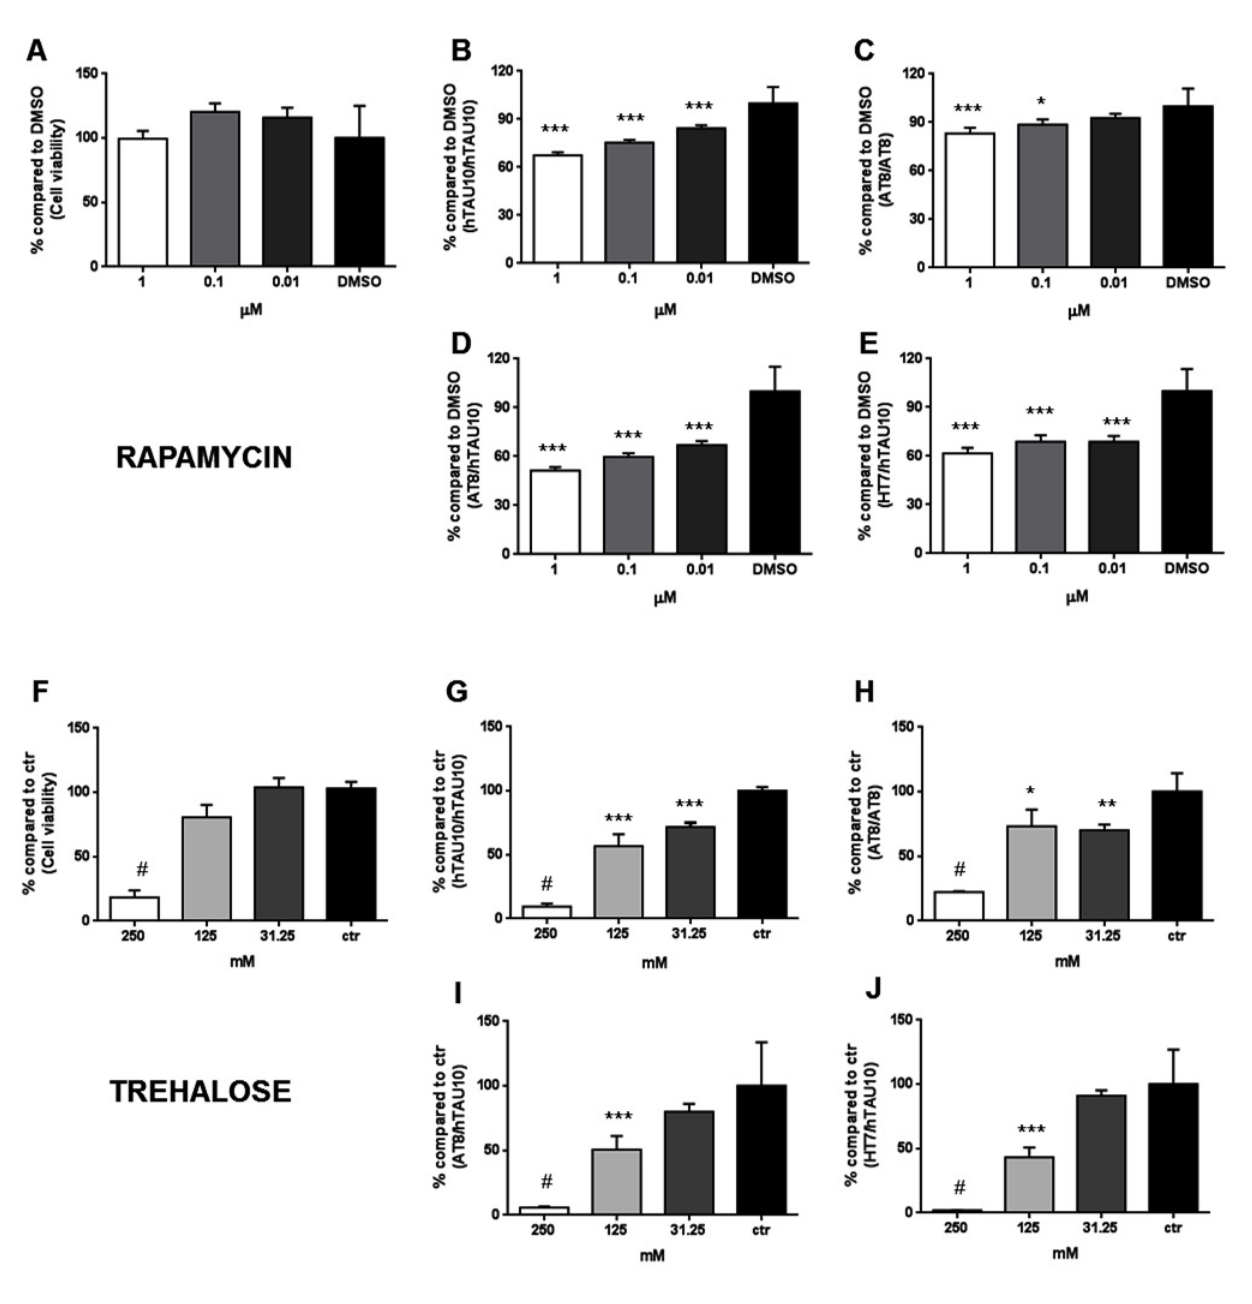
Fig 5. Model validation: autophagy inducers reduce TAU hyperphosphorylation and aggregation in TAU-P301L neurons. (A) CellTiter-Glo 1 data showing that rapamycin is not toxic (P = NS). (B, C) Rapamycin dose-dependently reduces hTAU10 (P < 0,001; B) and AT8 aggregated TAU measured with AlphaLISA (P = 0,025 at 10 nM and P < 0.001 at 1 μ M; C) and compared to DMSO. (D, E) Also general TAU phosphorylation is reduced (AT8/hTAU10; P < 0,001; D) to a similar extent as the reduction in total TAU (HT7/hTAU10; P < 0,001; E). (F) CellTiter-Glo 1 results show that trehalose is highly toxic at 250 mM (P < 0,001). (G, H) AlphaLISA results reveal that trehalose significantly reduces hTAU10 (P < 0,001) and AT8 TAU aggregation levels versus control (P = 0,006 at 31,5 mM and P = 0,014 at 125 mM). (I, J) Only at 125 mM of trehalose, both phosphorylated TAU (P < 0,001, I) and total TAU levels (P < 0,001, J) are decreased. *** P < 0,001; ** P < 0,01; * P < 0,05; # P < 0,001 due to toxicity; 1-way ANOVA with Dunnett ’ s post hoc; n (cid:1) 3 independent experiments